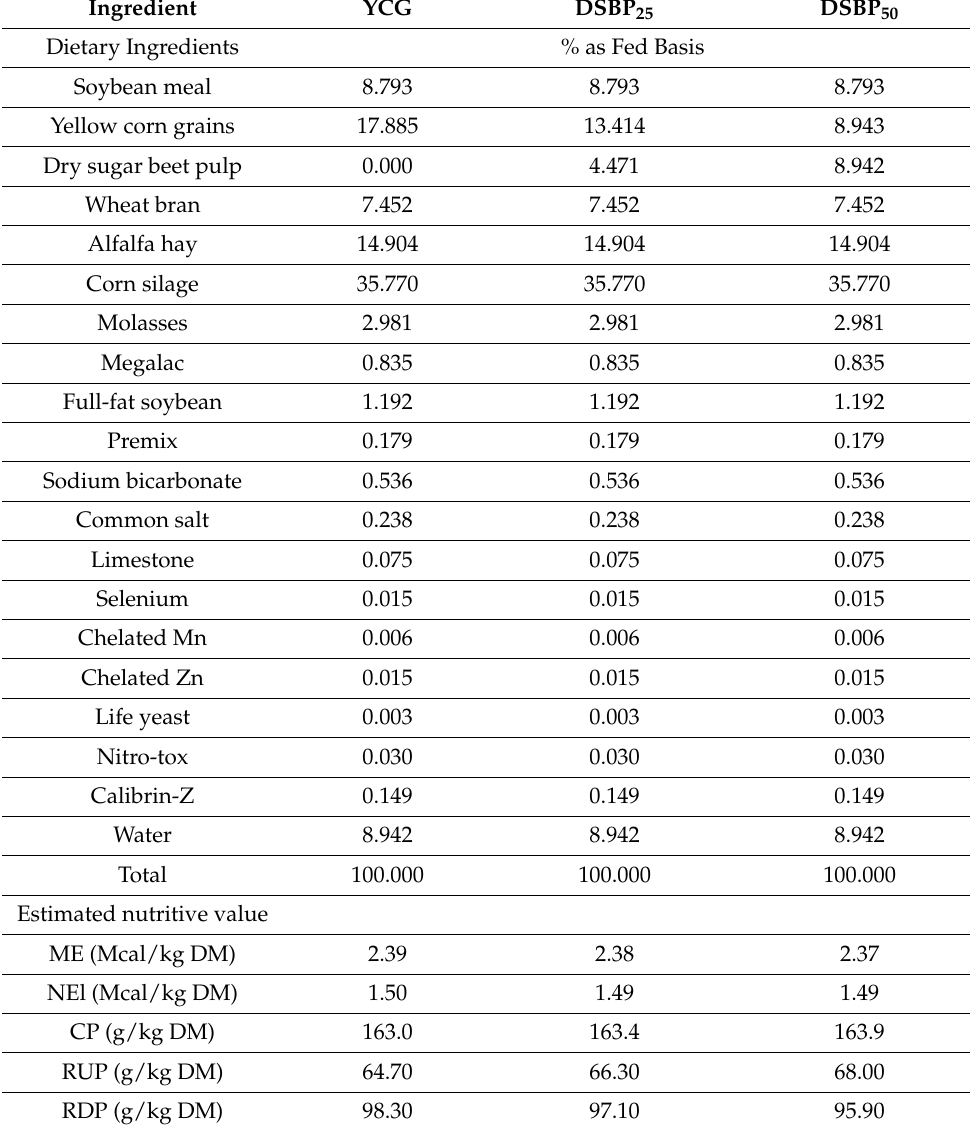
Table 1. Dietary ingredients for all the experimental